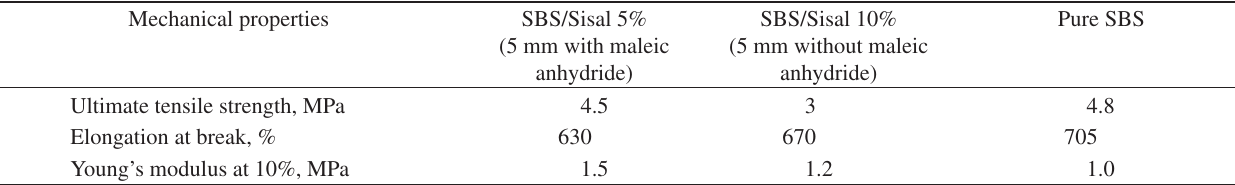
Table 4. Ultimate tensile strength, Elongation at break and Young’s modulus at 10% of SBS/sisal and pure SBS processed in a double-screw extruder. Mechanical properties